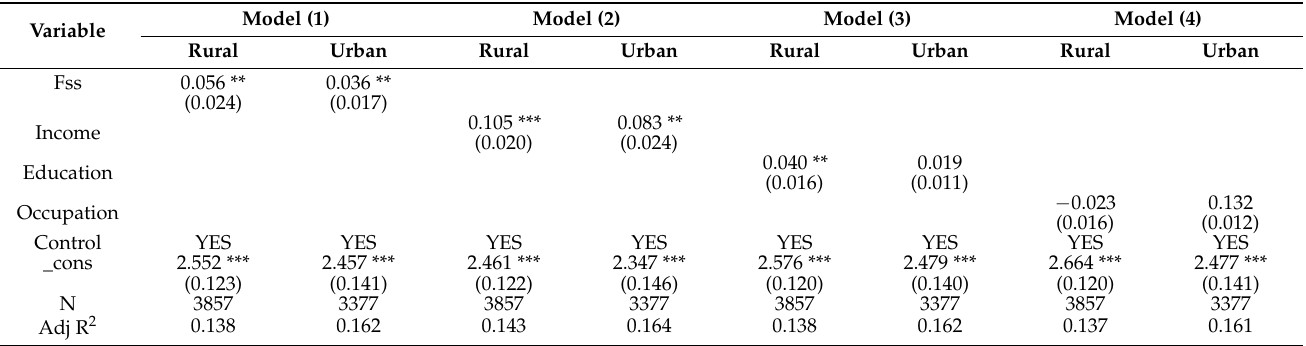
Table 7. Heterogeneity of registered residence